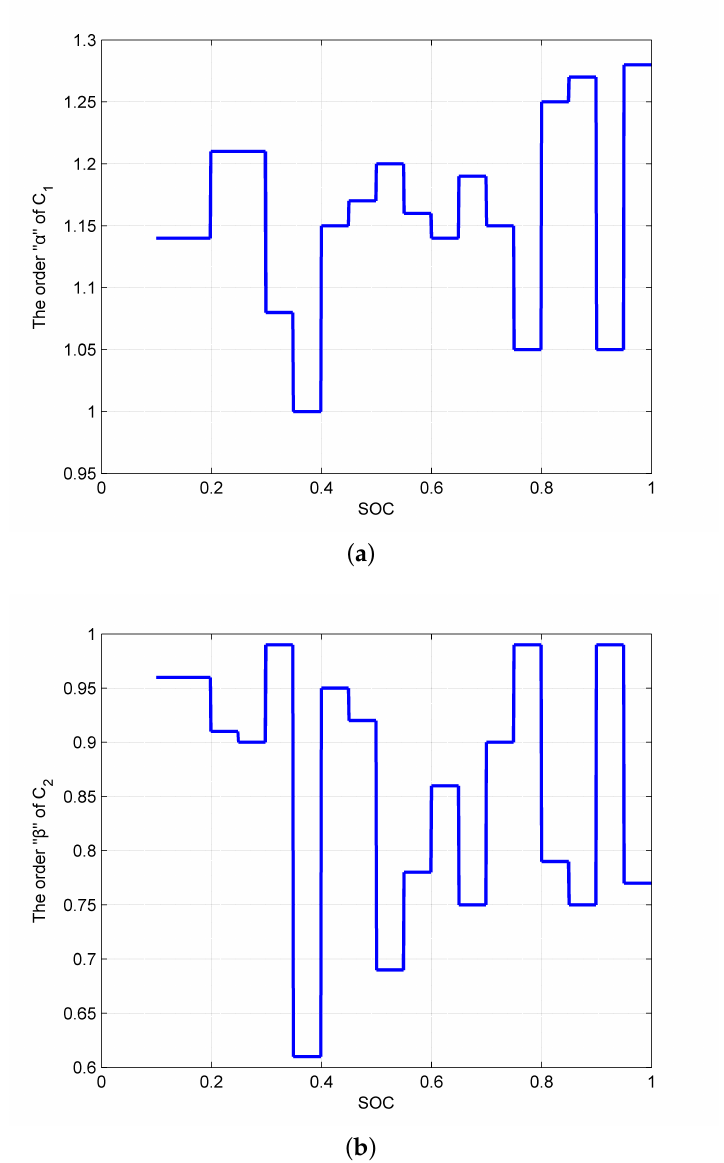
Figure 5. The orders of the capacitors. ( a ) The order α of C 1 with respect to SOC; ( b ) The order β of C 2 with respect to